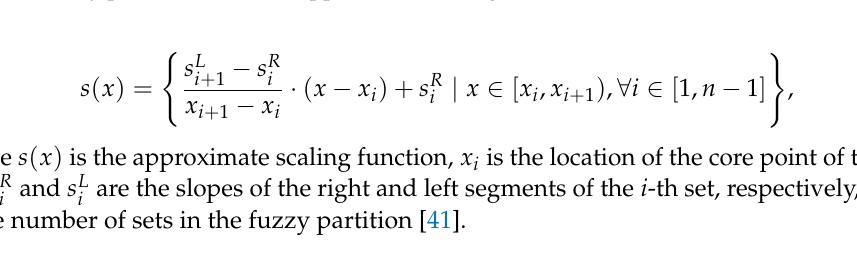
Figure 4. Fuzzy partition ( left ) and approximate scaling function ( right